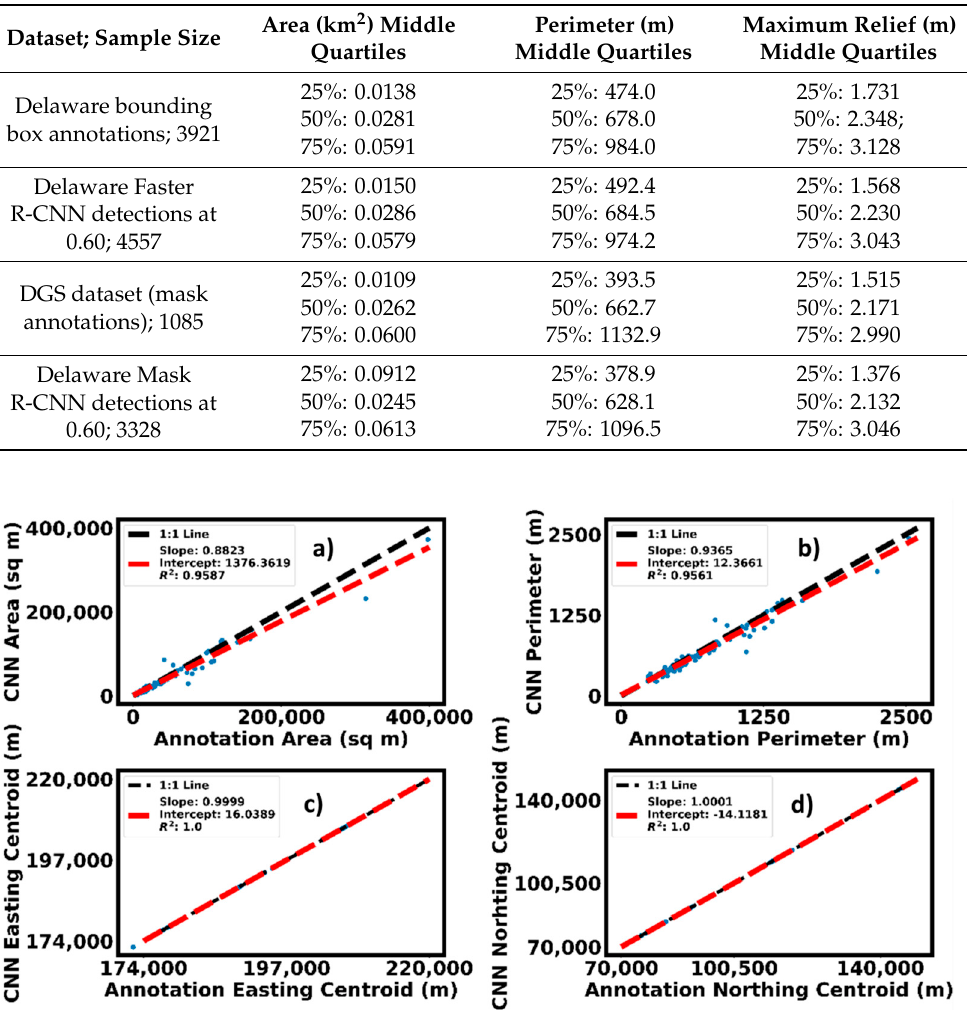
Figure 10. Comparing annotated bounding boxes with detection bounding boxes. ( a ) Bounding box area. ( b ) Bounding box perimeter. ( c ) Bounding box easting centroid. ( d ) Bounding box northing centroid.